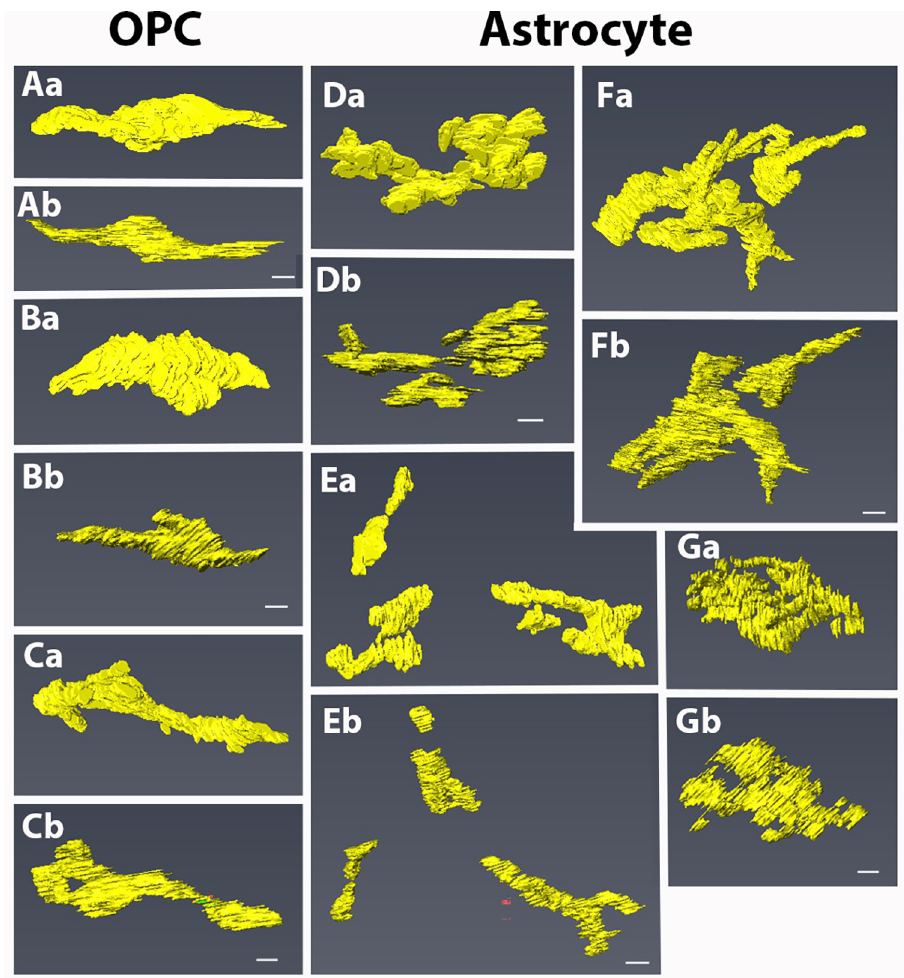
Fig 4. 3D reconstruction of Golgi apparatus in OPCs (A–C) and astrocytes (D–G). a and b are the same Golgi apparatus viewed from different directions. Golgi apparatus in OPCs are composed of one or two cisternae while those in astrocytes are composed of several cisternae, sometimes separately distributed in the cell (E). Bars = 1 μ